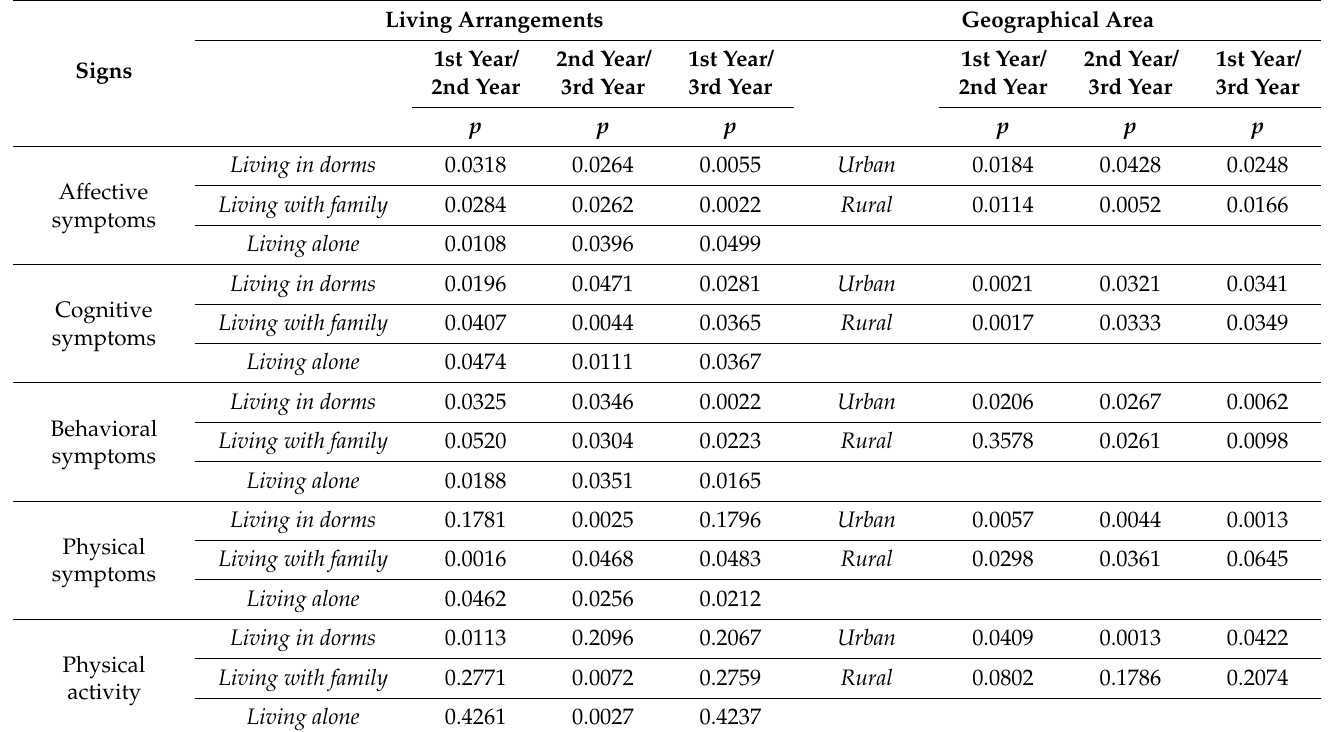
Table 4. Effects of living arrangements and geographical area on students’ symptoms between study year during lockdown ( t -test).